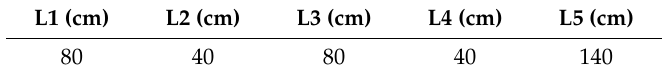
Table 1. Straight pipe length of a gas–solid two-phase pipeline.